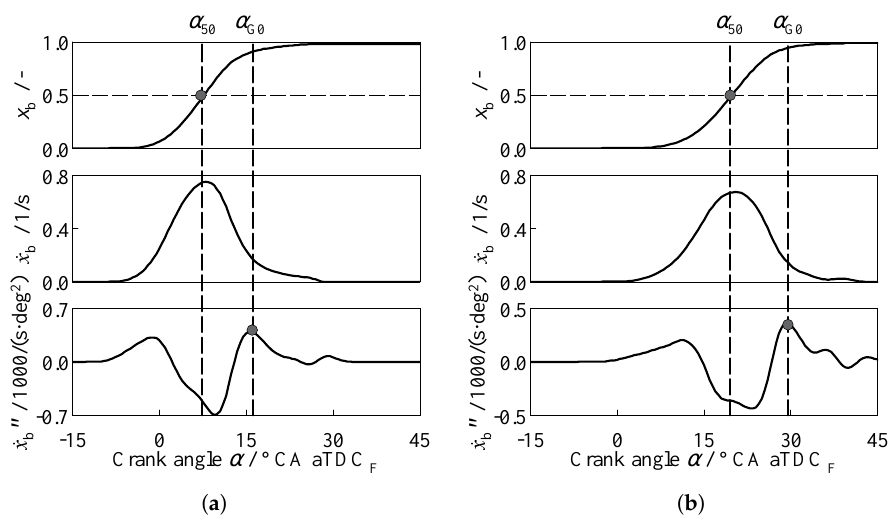
Figure 3. Example of G -equation deactivation angle calculation on the basis of the measured (TPA) burning functions ( x b ) for two operating points [25]. ( a ) LS2; ( b )